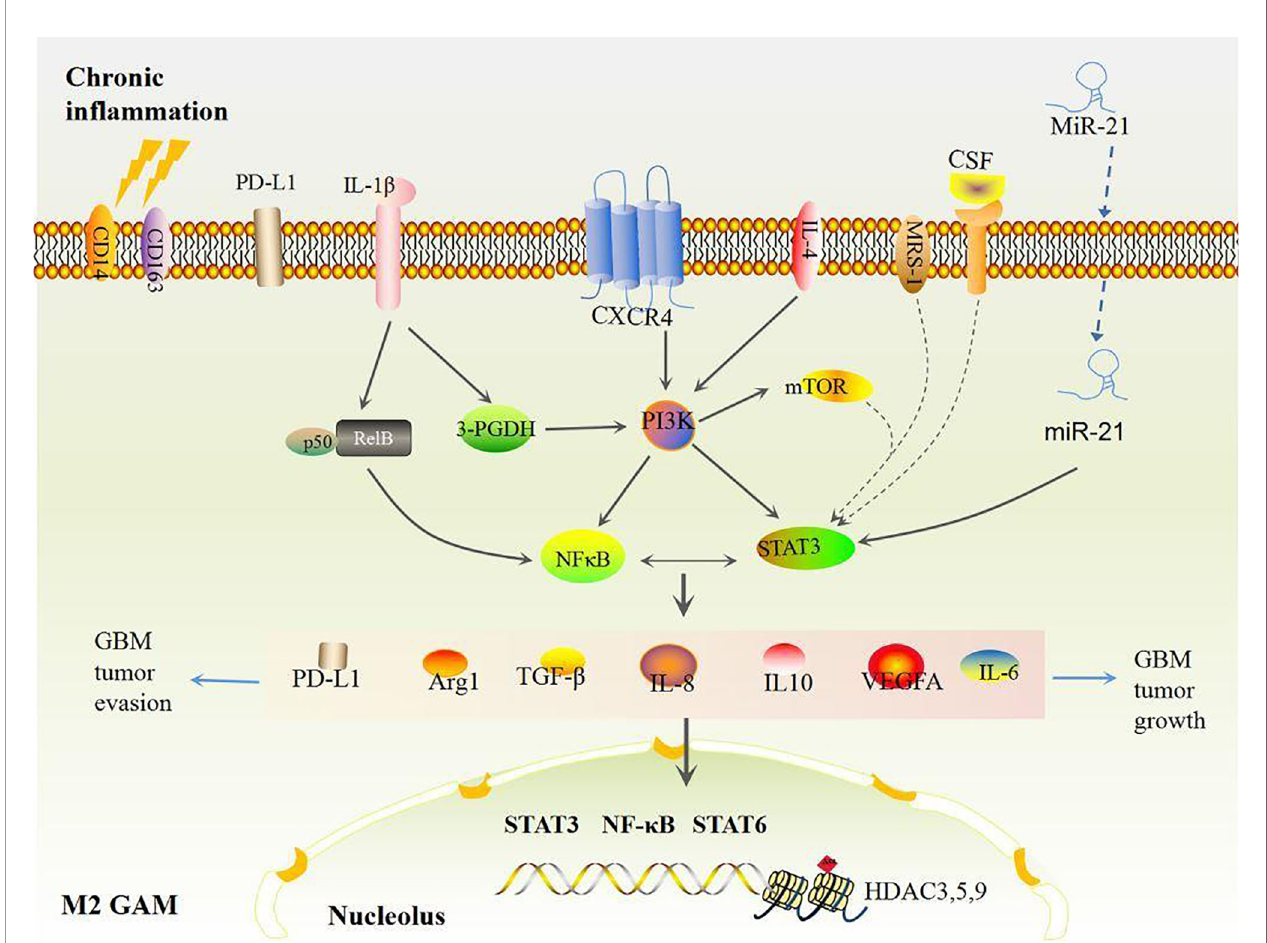
FIGURE 2 | Chronic in fl ammation induced M2 GAMs. Under chronic in fl ammation, most GAMs are polarized to the M2 type by STAT3 and NF k B activation, which produces high levels of VEGF and immunosuppressive factors including IL-6, IL-8, IL-10, Arg1, TGF- b , and PD-L1, eventually inducing more M2 polarizations and accelerating GBM growth and evasion in